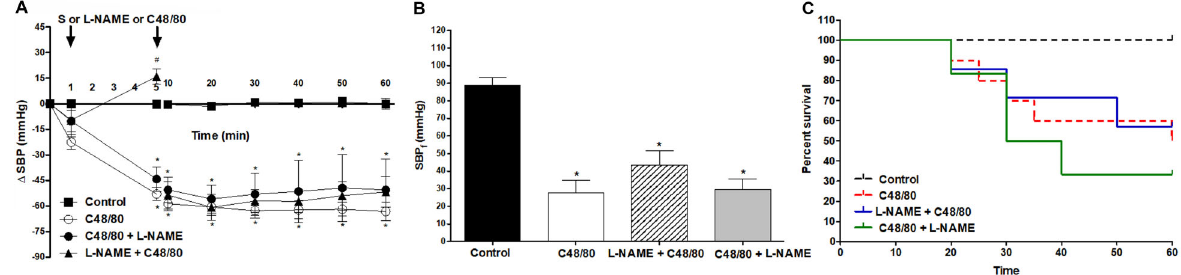
Figure 4. A , Systolic blood pressure (SBP), B , fi nal systolic blood pressure (SBP f ), and C , survival measurements of rats that received C48/80 and/or L-NAME (Kaplan-Meier, n=6). Data are reported as mean ± SE. A : *P o 0.001 C48/80, C48/80 + L-NAME, L-NAME + C48/